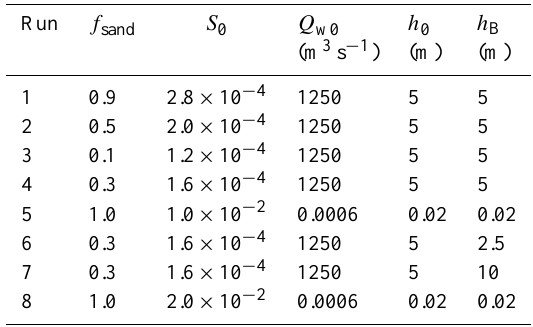
Table 2. List of delta model runs and parameter